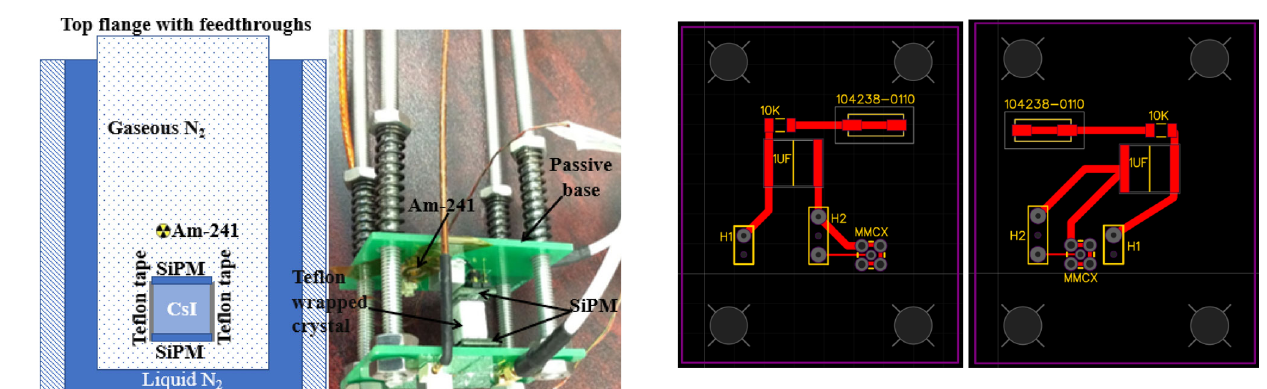
long. The chamber was vacuum sealed on both ends by two and attached to the chamber with a copper gasket in